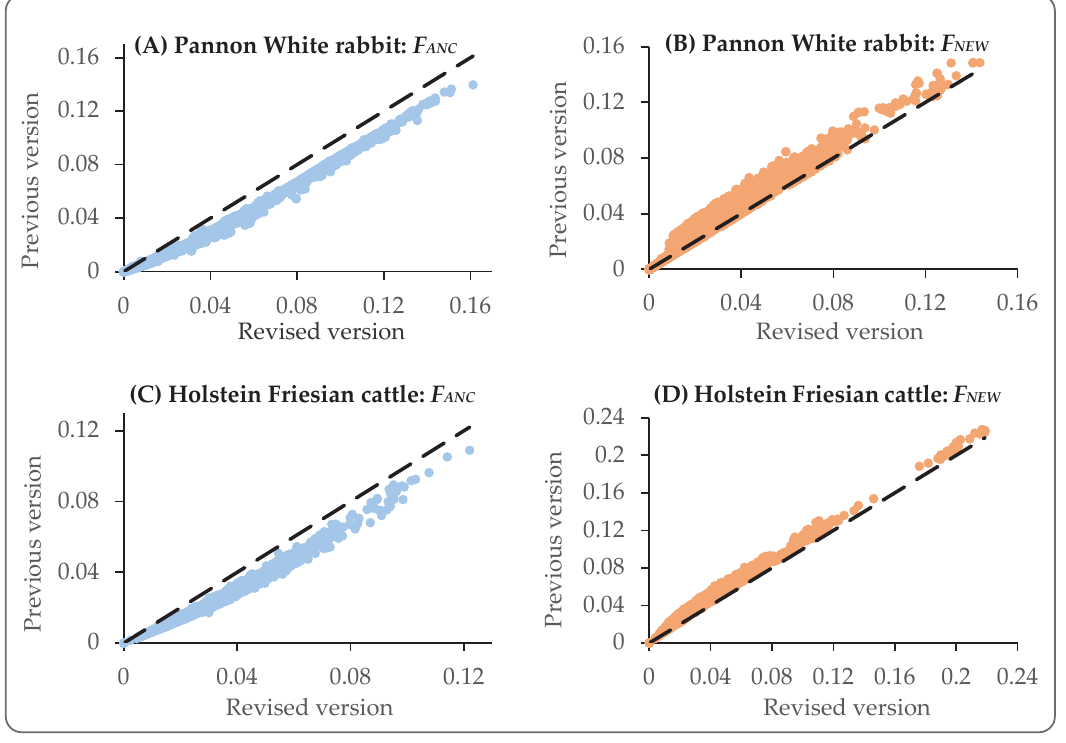
Figure 2. Relationship between Kalinowski’s inbreeding coefficients calculated with previous (v 2.1) and revised (v 2.2) version of GRain, for example data sets of Pannon White rabbits (PW; n = 22,781) and Holstein Friesian cattle (HF; n = 37,061). The dashed line indicates y = x , i.e., a relationship in which there is no difference in estimation between the two GRain versions. F ANC : Kalinowski’s ancestral inbreeding coefficient. F NEW : Kalinowski’s new inbreeding coefficient. ( A ) F ANC for the PW data set, ( B ) F NEW for the PW data set, ( C ) F ANC for the HF data set, and ( D ) F NEW for the HF data set. For the Holstein Friesian data set, we also investigated the potential differences in inbreeding depression estimates for F ANC and F NEW, calculated with the previous and revised version of GRain. A linear mixed model was run in ASReml 4.1 [22], in which F ANC and F NEW were fitted as fixed effects and the regression coefficients on F ANC and F NEW were used as estimates of inbreeding depression (see Doekes et al. [21] for a detailed explanation). In general, differences between inbreeding depression estimates based on the previous and revised version of GRain were small (Figure 3). For example, the effect of a 1% increase in F NEW on 305-day milk yield was (cid:442) 46.4 kg (SE = 12.4 kg) for the previous version and (cid:442) 47.3 kg (SE = 11.2 kg) for the revised version. Standard errors for the inbreeding